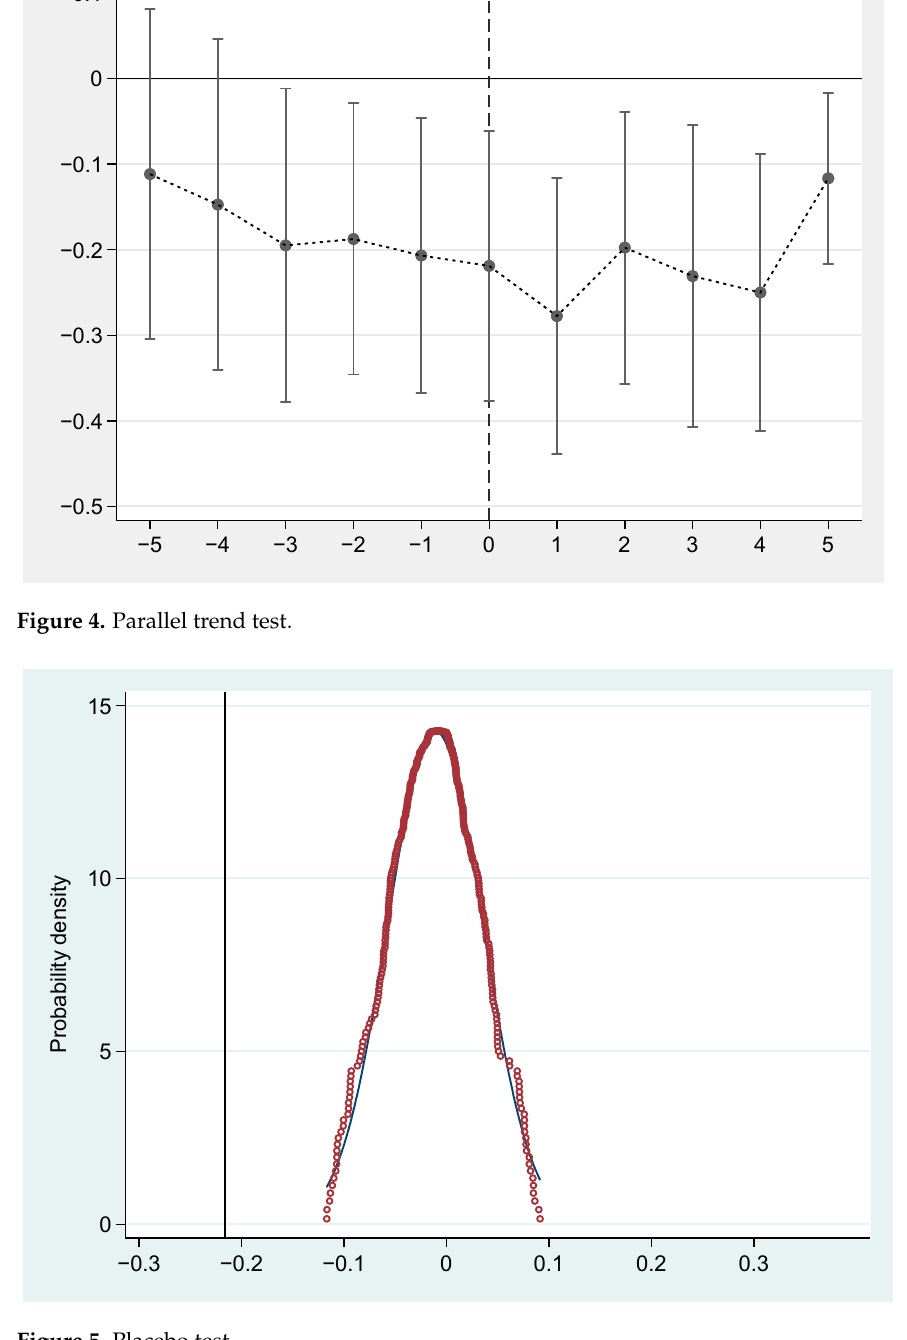
Figure 5. Placebo test.